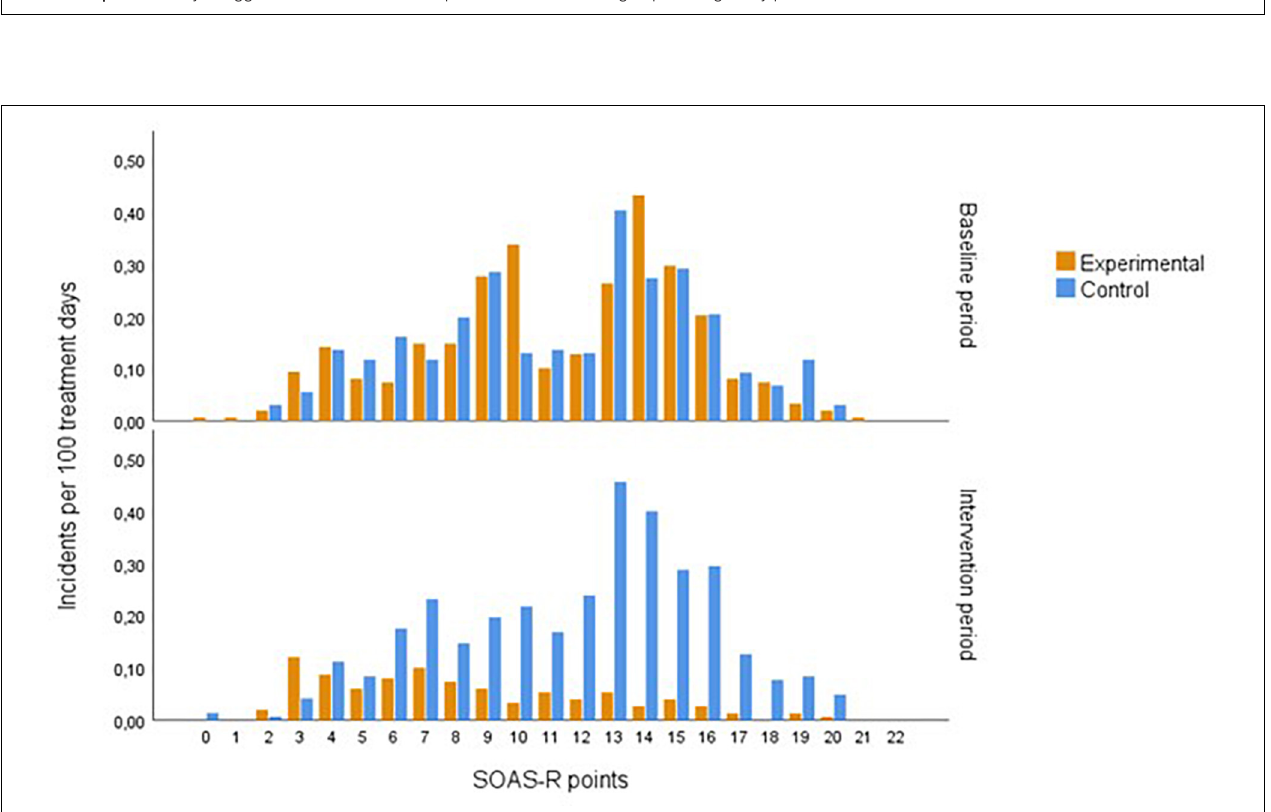
FIGURE 3 | The severity of aggressive incidents in the experimental and control groups during study periods.